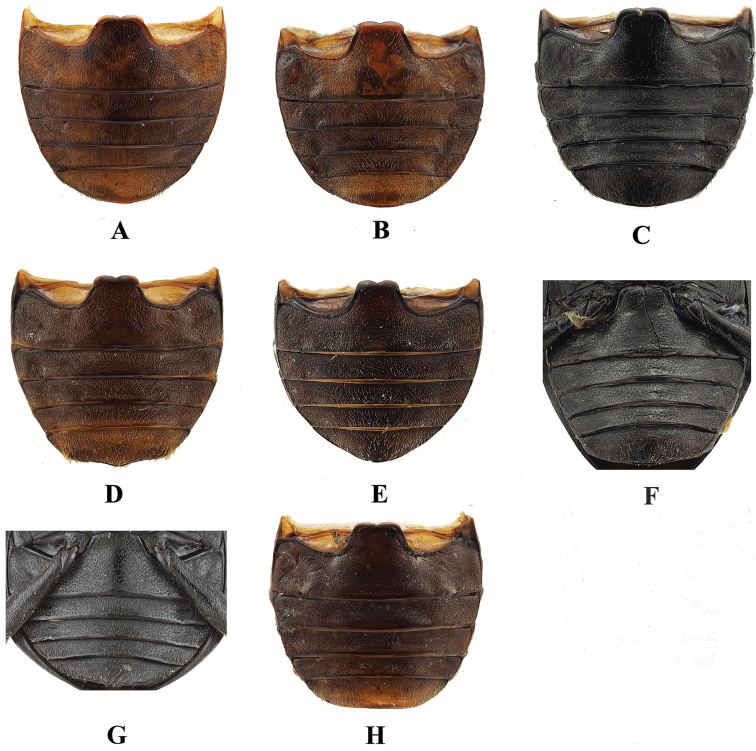
Male abdomen of Sinocymbachus spp AS.
angustefasciatusBS.
bimaculatusCS.
decorusDS.
excisipesES.
humerosusFS.
luteomaculatusGS.
parvimaculatusHS.
quadrimaculatus.